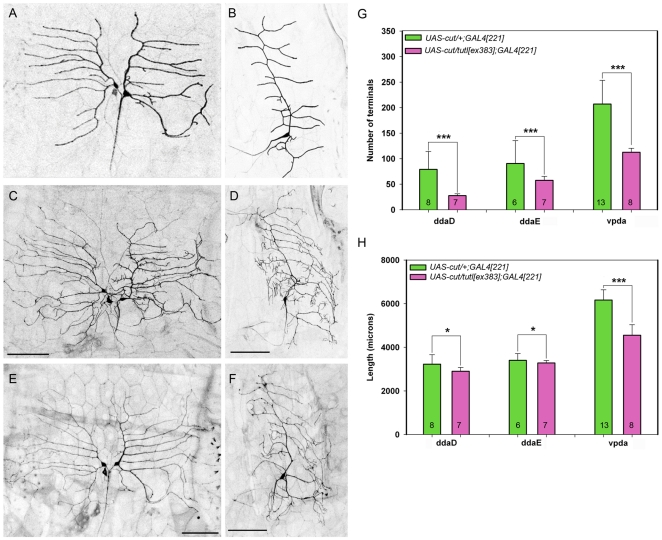
Tutl functions as a downstream effector of Cut-mediated regulation of da neuron dendrite development.(A–F) Live confocal images of representative class I da neurons (ddaD, ddaE, vpda) at the third larval instar. Images were collected at 20X magnification and size bars represents 100 microns. (A,B) Representative images of wild-type dorsal ddaD/E neurons (A) and ventral vpda neuron (B) ectopically overexpressing Cut. (C,D) Representative images of dorsal ddaD/E neurons (C) and ventral vpda neuron (D) ectopically overexpressing Cut. Note, ectopic overexpression of Cut results in class I neurons displaying increased dendritic branching complexity characterized by a high incidence of short dendritic protrusions emanating from the primary branches as compared to wild-type. (E,F) Representative images of dorsal ddaD/E neurons (E) and ventral vpda neuron (F) in which ectopic overexpression of Cut is combined with the tutlex383 allele. As compared to Cut overexpression alone, introduction of one copy of the tutlex383 mutant allele results in strong suppression of the Cut phenotype particularly with respect to the incidence of short dendritic protrusions. (G) Quantitative analyses reveal that the total number of dendritic terminals is significantly reduced in animals carrying one copy of the tutlex383 mutant allele relative to Cut ectopic overexpression alone. (H) Quantitative analyses reveal a modest, yet statistically significant, decrease in overall dendritic length in animals carrying one copy of the tutlex383 mutant allele relative to Cut ectopic overexpression alone. The total n value for each neuron subtype is indicated on the bar graph. Statistically significant p values are reported on the graphs as follows (* = p<0.05; *** = p<0.001). Genotypes: (A,B) GAL4221,UASmCD8::GFP/+; (C,D) UAS-cut/+; GAL4221,UASmCD8::GFP/+; (E,F), UAS-cut/tutlex383; GAL4221,UASmCD8::GFP/+.